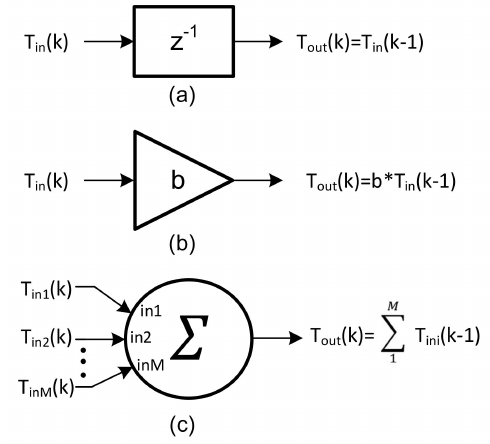
Figure 2. Time-mode operators ( a ) z − 1 , ( b ) z − 1 multiplier and ( c )